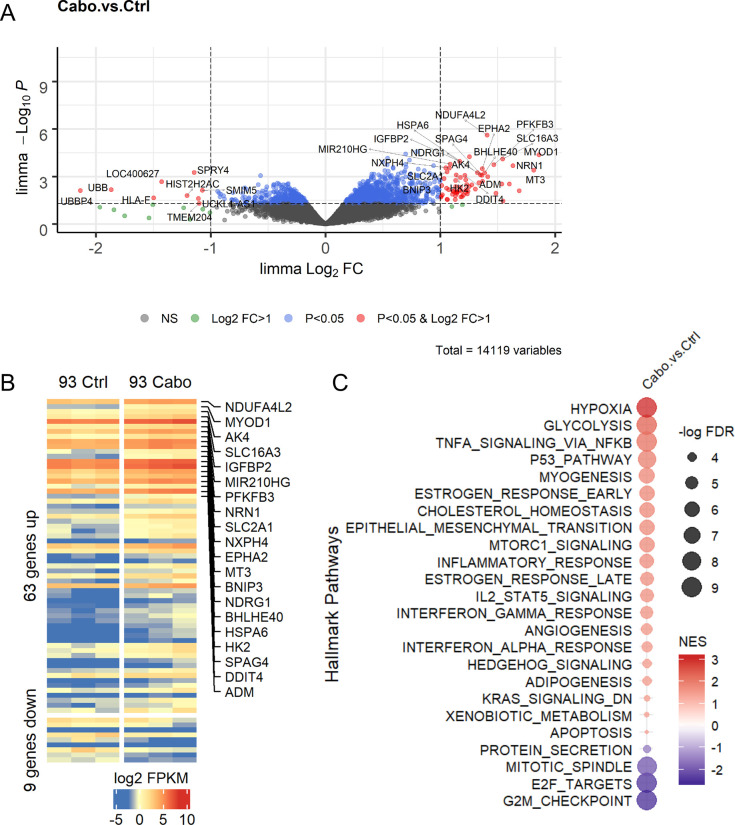
RNA-Seq and pathway analysis of LuCaP 93 tumors from cabozantinib-treated animals compared to tumors from vehicle treated animals.RNA was isolated for RNA-Seq from vehicle control (n = 3) and cabozantinib-treated (n = 3) LuCaP 93 tumor bearing animals. (A) Volcano plot representing up- and downregulated genes in response to cabozantinib treatment. Statistically significant changes in gene expression were based on limma and only included genes with p<0.05 and log2 Fold Change (FC)>1. Data points are colored according legend; NS = not significant. (B) Unsupervised clustering heatmap of significantly altered genes in response to cabozantinib treatment in LuCaP 93 PDX tumors. The top 20 upregulated genes are labeled. Data represents log2 FPKM values and are colored according to scale. (C) GSEA of significantly altered genes from (B) using the hallmark gene sets in MSigDB. Ctrl: vehicle control; Cabo: cabozantinib.